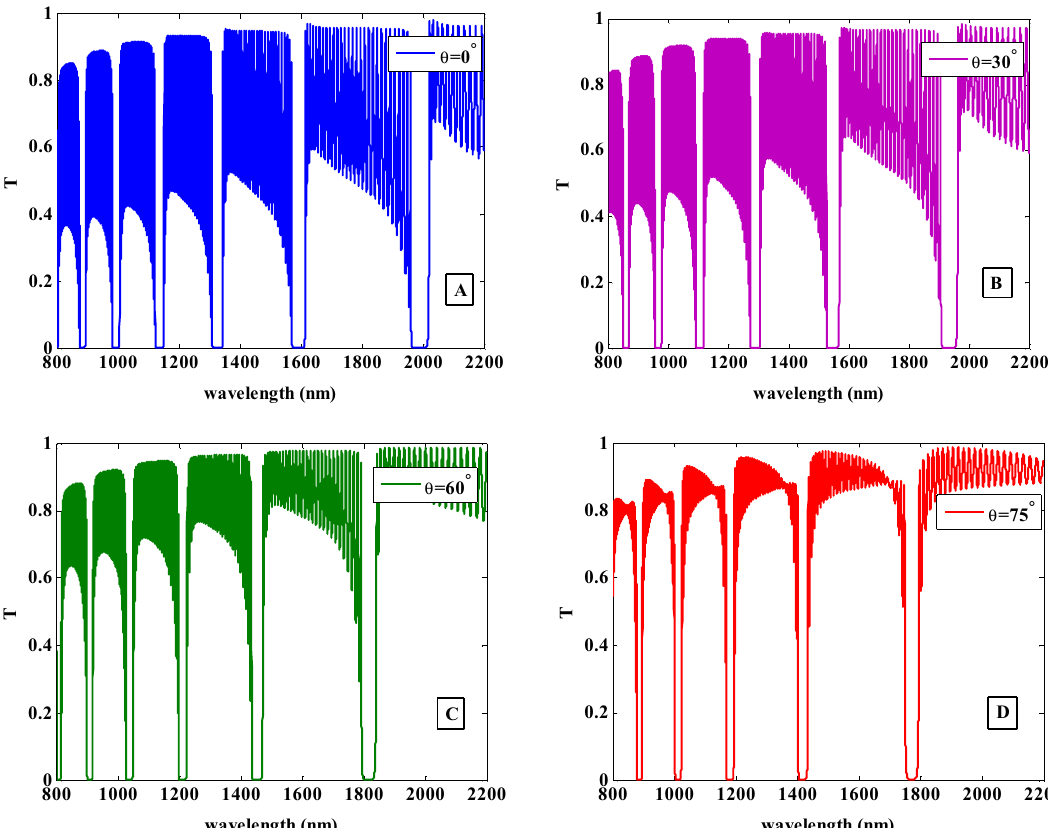
Figure 9. The transmittance spectra of the one-dimensional photonic crystal containing HMM at different incident angles for TM